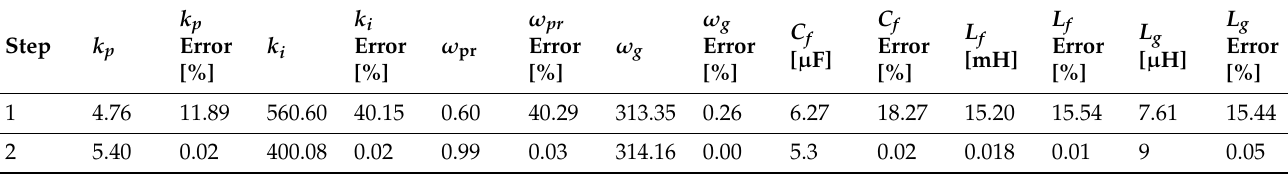
Table 6. Parameter estimation results of the grid-tied